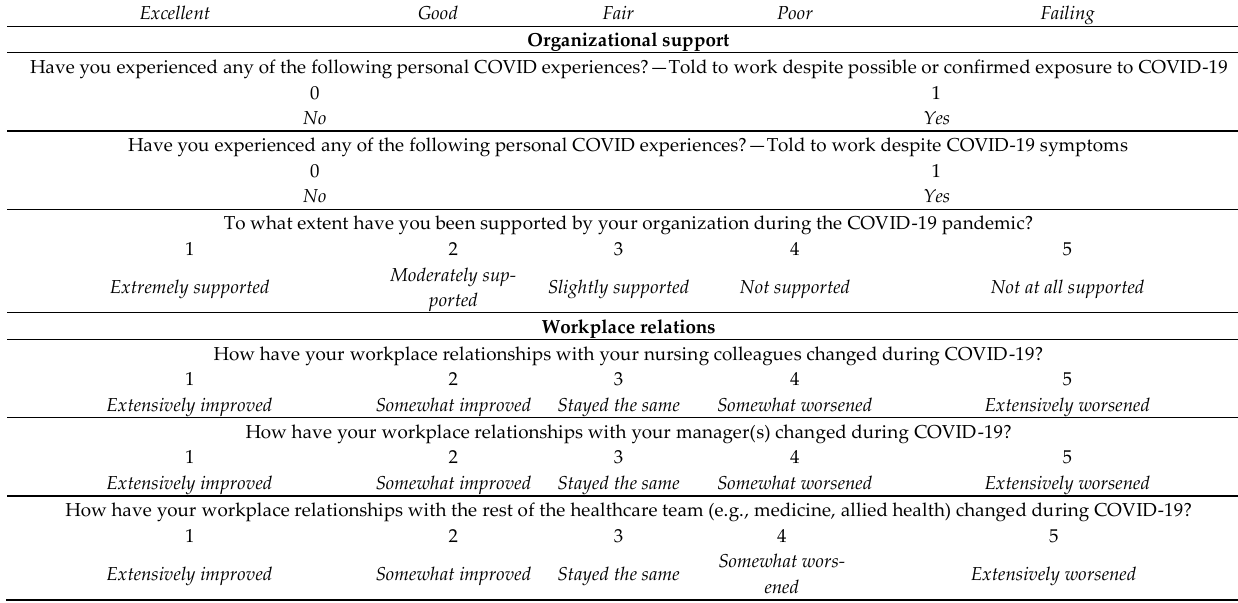
Figure 1. Workplace conditions questions and their response scales for each domain. PPE = personal protective equip- ment.